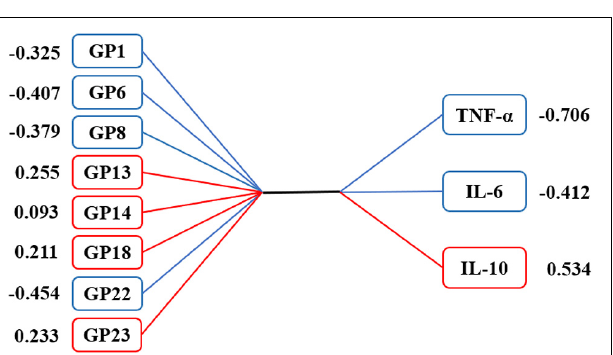
FIGURE 4 | Canonical structures of initial glycans and inflammation markers in the first canonical set of canonical correlation analysis. The absolute value of canonical loadings greater than 0.300 was a significant loading. The positive relationships are shown in red boxes, while negative relationships are shown in blue boxes. GP, glycan peak; hs-CRP, high-sensitivity C-reactive protein; IL-4, interleukin-4; IL-6, interleukin-6; IL-10, interleukin-10; TNF- α , tumor necrosis